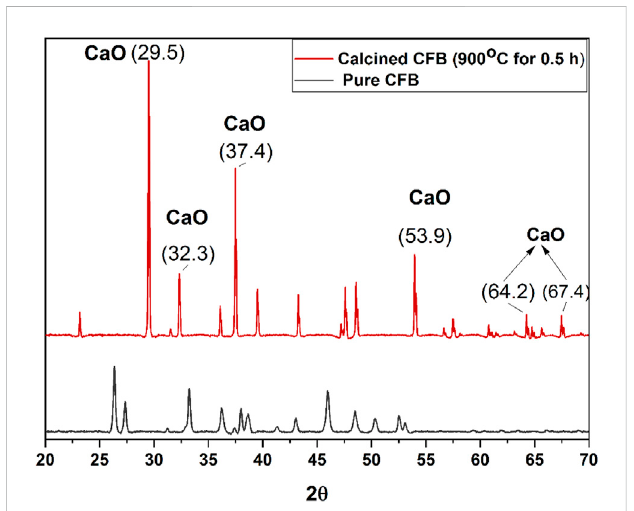
FIGURE 9 TGA and DTA curves of CFBP raw